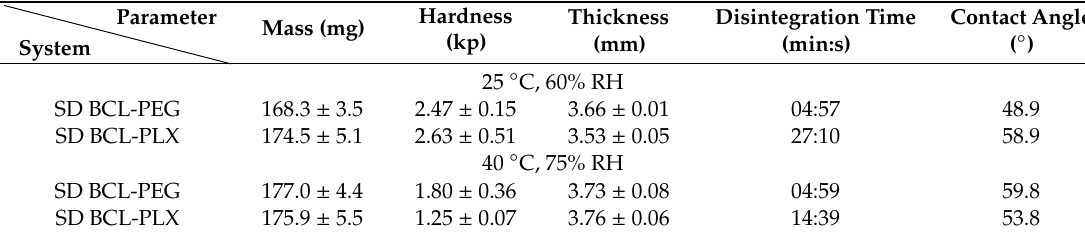
Figure 9. Diffraction patterns of bicalutamide in tablets with solid dispersions after stability studies. 4. Conclusions This study has examined the effect of supercritical carbon dioxide treatment on the properties of binary systems containing bicalutamide and Macrogol 6000 or Poloxamer® 407. The dissolution and attributes of tablets were evaluated. The scCO 2 influenced not only the size and shape of the particles of the processed substances, but also the dissolution characteristics of bicalutamide from solid dispersions. Supercritical conditions induced a decrease in the crystallinity of the active substance. The obtained solid dispersions were successfully formulated in tablets. The tableting process induced the amorphization of the drug substance. This phenomenon confirmed the sensitivity of bicalutamide on mechanical activation. After 1h, the amount of bicalutamide dissolved